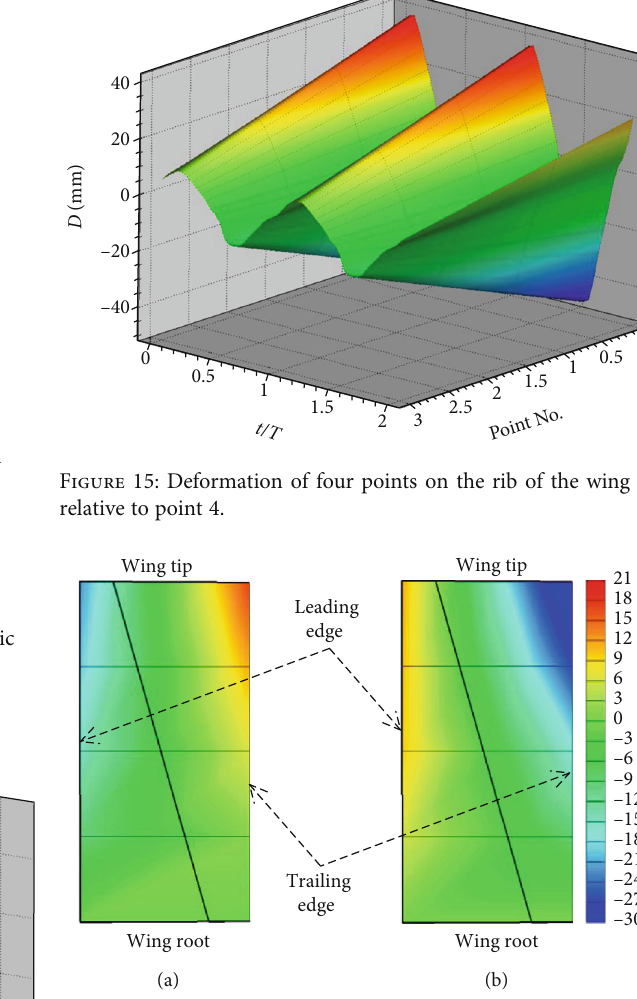
Figure 16: Deformation contour in a fl apping cycle: (a) t / T = 0 : 1 ; (b) t / T = 0 : 6